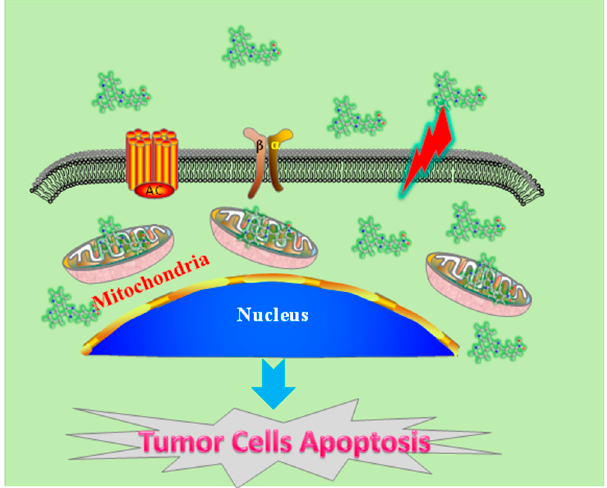
Figure 5. Tumor cells apoptosis induced by imidazole[4,5- f ][1,10]phenanthroimidazole derivatives related to mitochondria-mediated pathway.